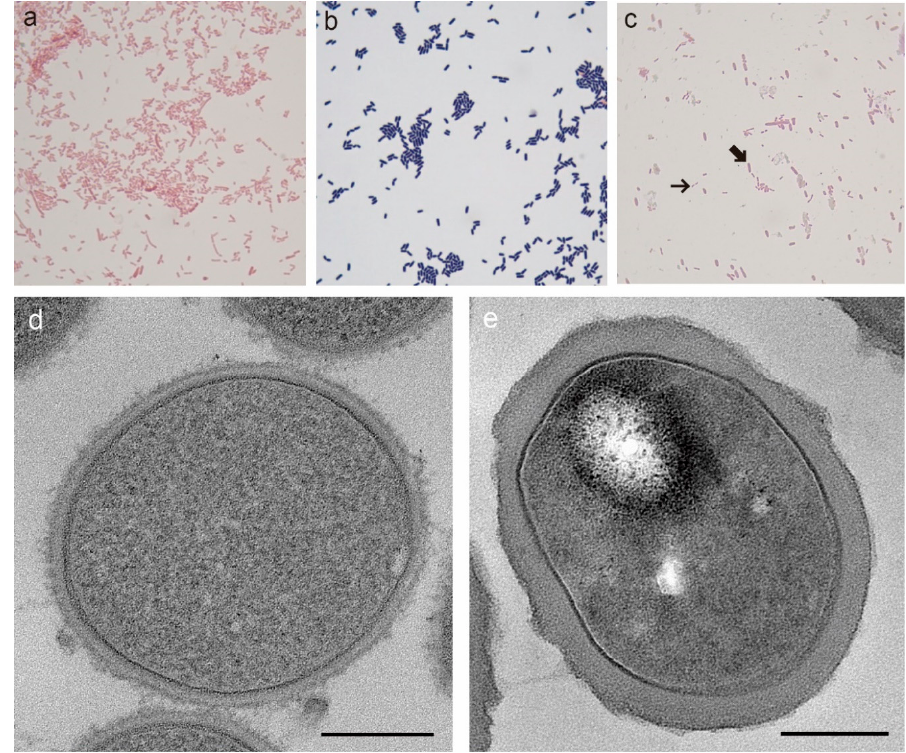
Figure 1. Microscopic images of strains. ( a – c ) Gram-stains of ( a ) L. iners KY. ( b ) L. plantarum . ( c ) artificial mixtures of L. iners KY (narrow arrow) and E. coli OP50 (wide arrow). ( d , e ) TEM images of cell envelopes of ( d ) L. iners KY. ( e ) L. plantarum . Both species were identically processed. It is shown that L. iners has the cell envelope organization of the Gram-positive organisms, but the thickness of the peptidoglycan layer is relatively thin compared to L. plantarum . Scale bar = 200